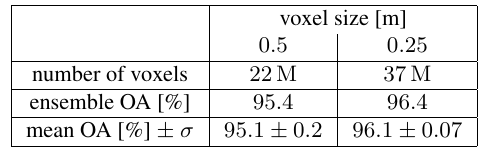
Table 2. AHN3 test results.